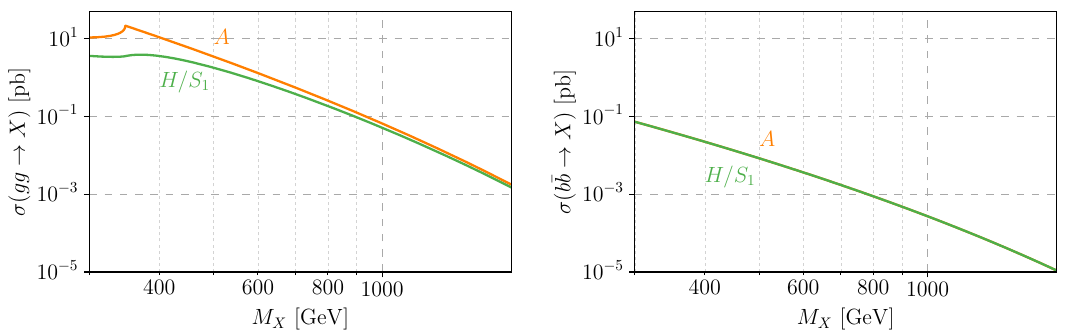
Figure 5 . Production cross sections for the heavy scalar H=S 1 and pseudoscalar A through gluon fusion (left) and b (cid:22) b initial state (right), in the 2HDM+PS/S as given in eq. (4.1). The plot depicts the case of tan (cid:12) =